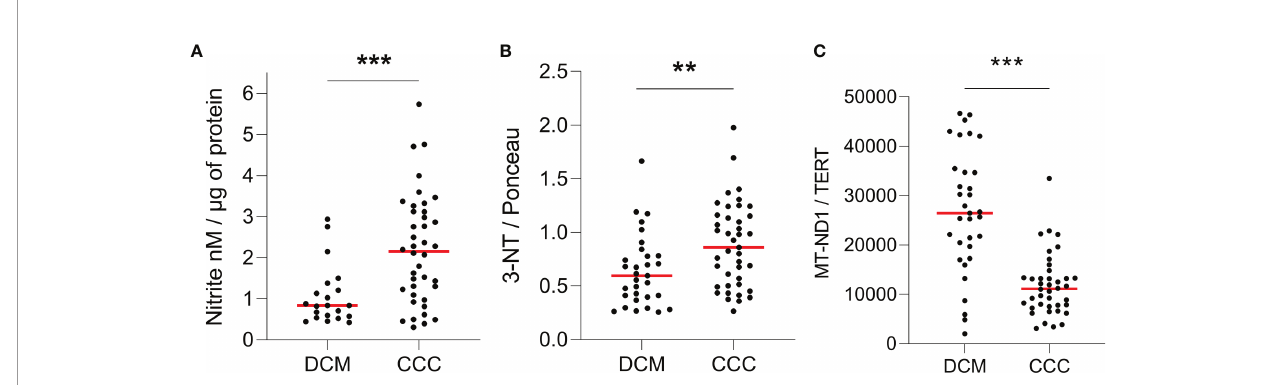
FIGURE 1 | Quanti fi cation of ROS, RNS and mitochondrial DNA in heart tissue. Lysates of left ventricular heart tissue were obtained from CCC (n = 40) and DCM (n = 31) patients and used for the quanti fi cation of (A) nitrite (nM) by chemiluminescence assay; (B) 3-nitrotyrosine by dot-blot and (C) copy number of the mitochondrial gene MT-ND1 by real time PCR. Red line: median; **p < 0.01; ***p < 0.001; Mann-Whitney test.